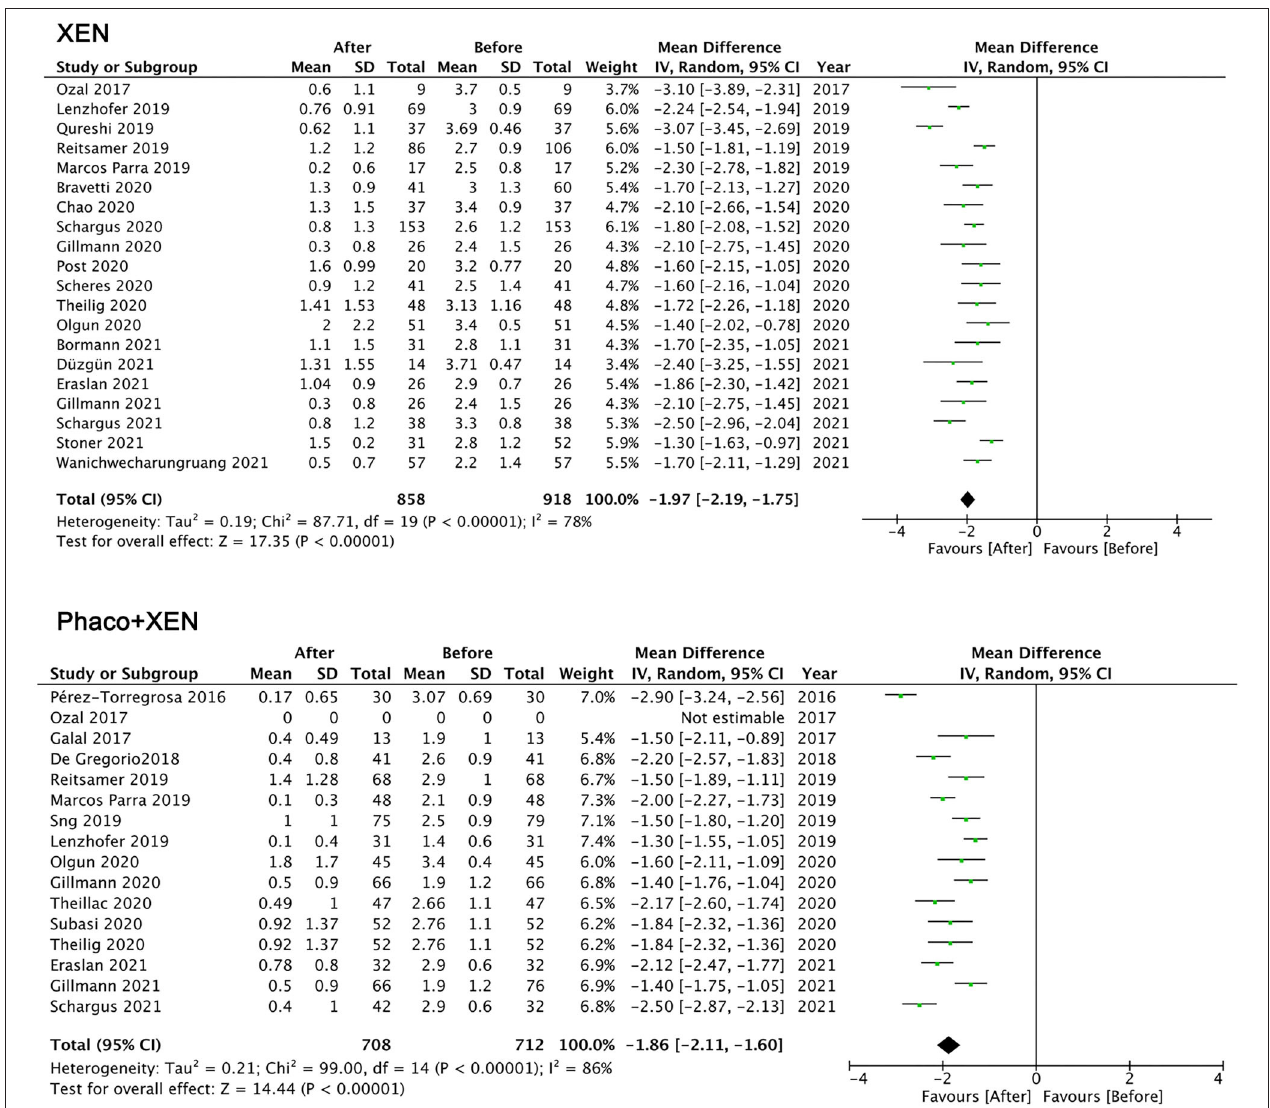
FIGURE 3 | Mean difference (MD) of the reduction in anti-glaucoma medications between the baseline and the final follow-up by XEN alone, phacoemulsification combined with XEN (phaco + XEN).